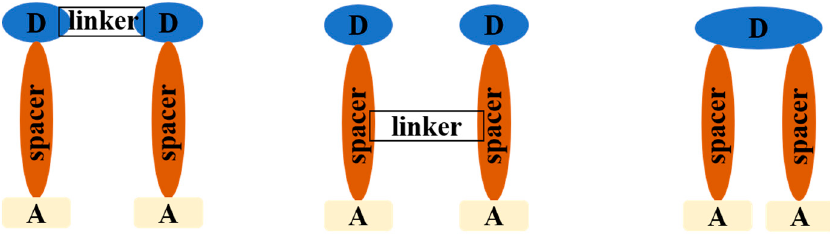
Figure 6. Schematic diagram of double branched dyes.